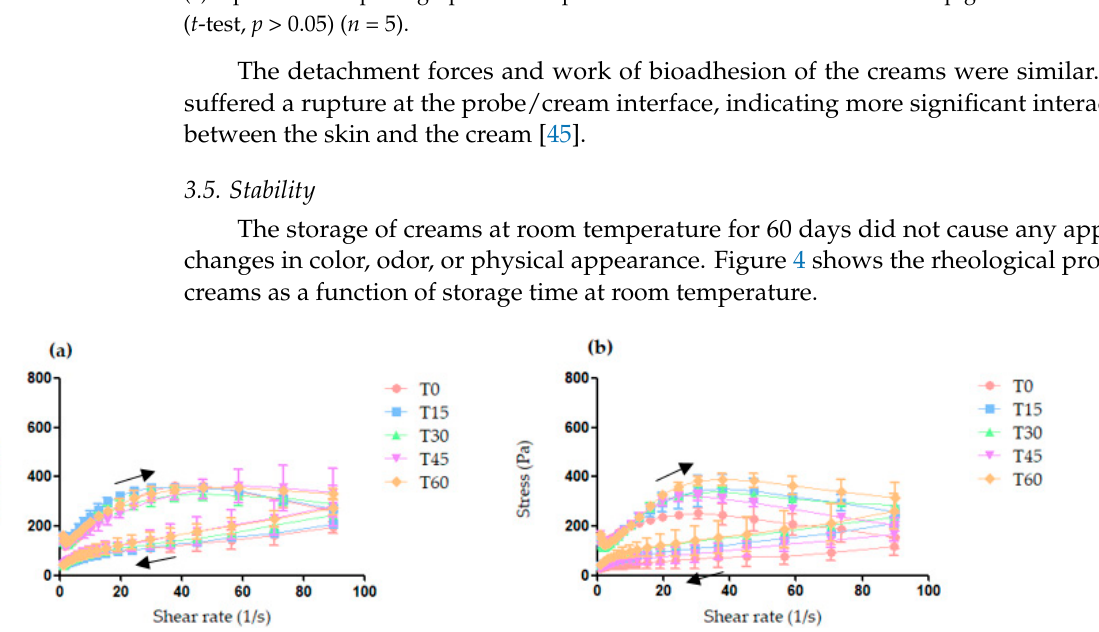
Figure 4. Rheological behavior of CBlank ( a ) and CPropolis ( b ) stored at room temperature, and evaluated soon after preparation (T0) and after 15 (T15), 30 (T30), 45 (T45), and 60 (T60) days. Arrows indicate the direction of the shear rate.